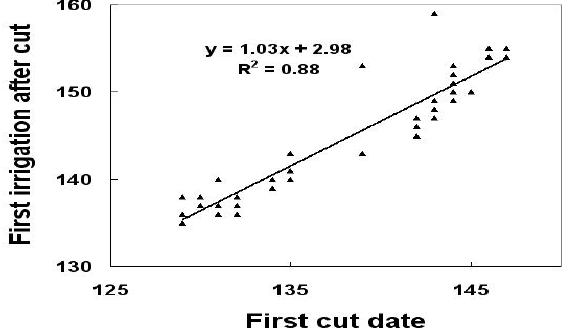
Fig.5. Relationshipobtainedbetweenthe1stmowingdateandtheirrigationdatejustafterthemowing,forthe Fig. 5. Relationship obtained between the 1st mowing date and the Figure 5 . Relationship obtained between the 1rst mowing date and the irrigation date just after differentgrasslandssurveyedovertheCrauregion. irrigation date just after the mowing, for the different grasslands the mowing, for the different grasslands surveyed over the Crau region. surveyed over the Crau